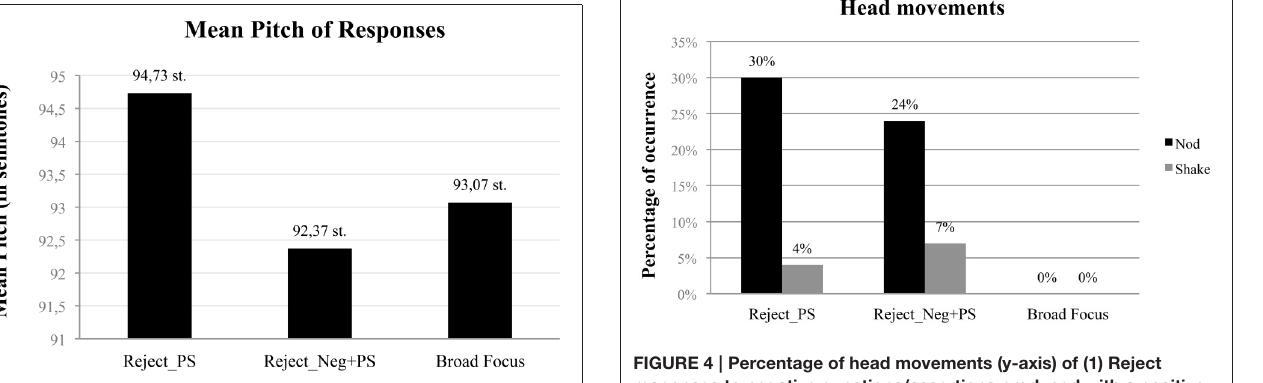
FIGURE 3 | MEAN PITCH (in semitones) (y-axis) of (1) Reject responses to negative questions/assertions produced with a positive sentence (left column), (2) Reject responses to negative questions/assertions produced with a negative particle followed by a positive sentence (middle column) and (3) Broad Focus responses (right column).